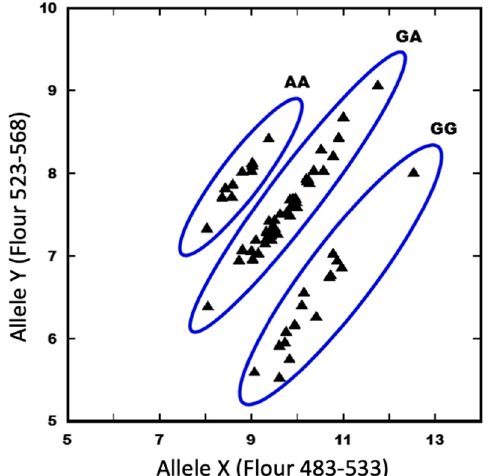
Figure 4. Genotyping of msd3-4 F 2 backcrossed population by KASP (Kompetitive Allele-Specific PCR) SNP (single nucleotide polymorphism) analysis. The x-axis represents the endpoint fluorescence data at 483–533 nm (allele X or wild type allele) and the y-axis represents the endpoint fluorescence data at 523–568 nm (allele Y or mutant allele). Genotype for individual F 2 plants was determined by cluster analysis of the endpoint KASP assay. AA, homozygous msd3-4 ; GG, homozygous wild-type (WT); and GA, heterozygous WT.